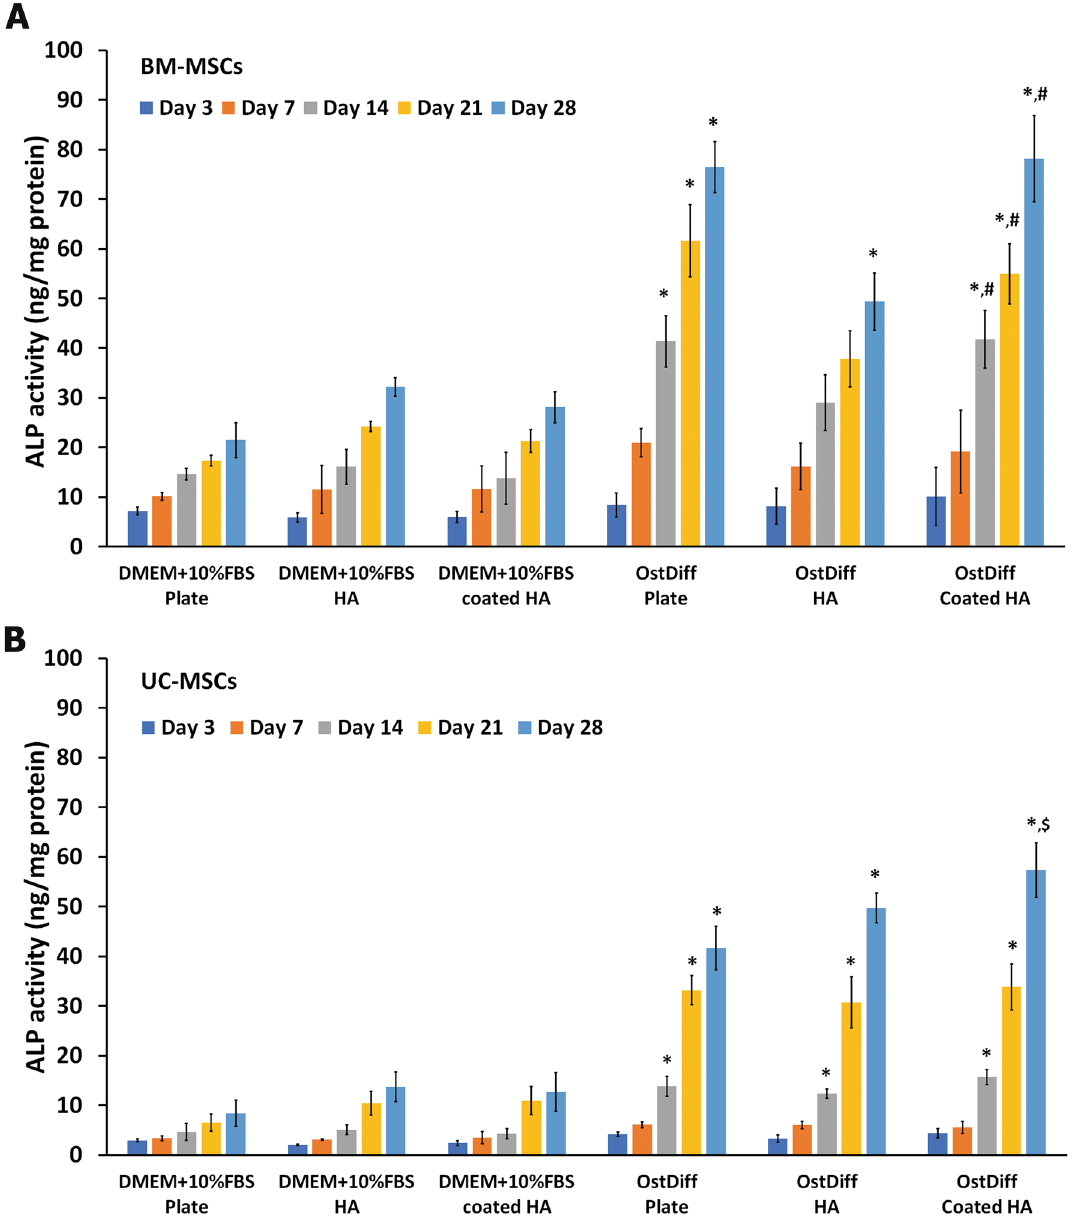
Figure 7. Alkaline phosphatase activity of BM-MSCs ( A ) and UC MSCs ( B ) cultured on the 3D-printed HA (HA) and coated 3D-printed HA (coated HA) compared with those cultured on a plastic culture plate at days 3, 7, 14, 21, and 28. N = 3, * P < 0.05, compared to MSCs cultured with DMEM + 10%FBS. # P < 0.05, compared to MSCs cultured with osteogenic differentiation medium on 3D-printed HA. $ P < 0.05 compared to MSCs cultured with osteogenic differentiation medium on a plastic culture